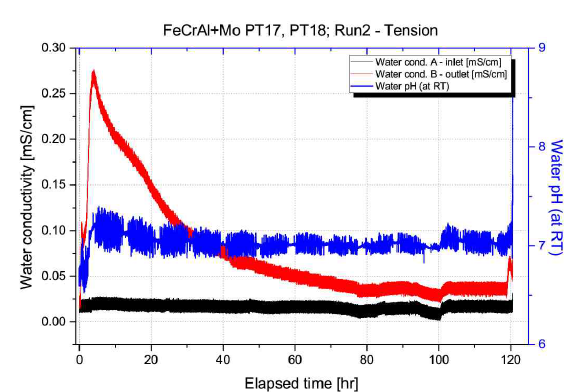
Figure 12. FeCrAl+Mo Run 2 - Water inlet and outlet conductivity and pH.